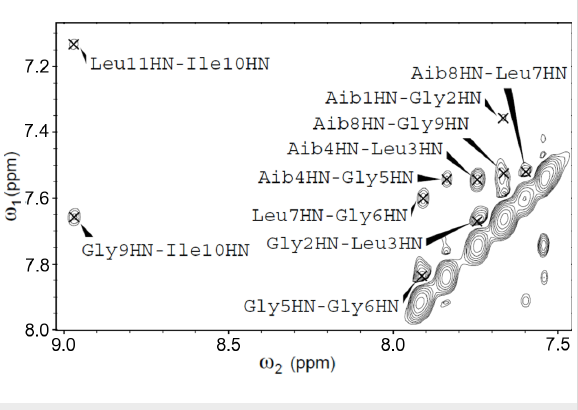
Figure 5: Region of the amide NH protons in the H/H-ROESY spec- trum of ψ [CS-NH] 9 (400 MHz, 1 mM in CD 3 CN solution, 298